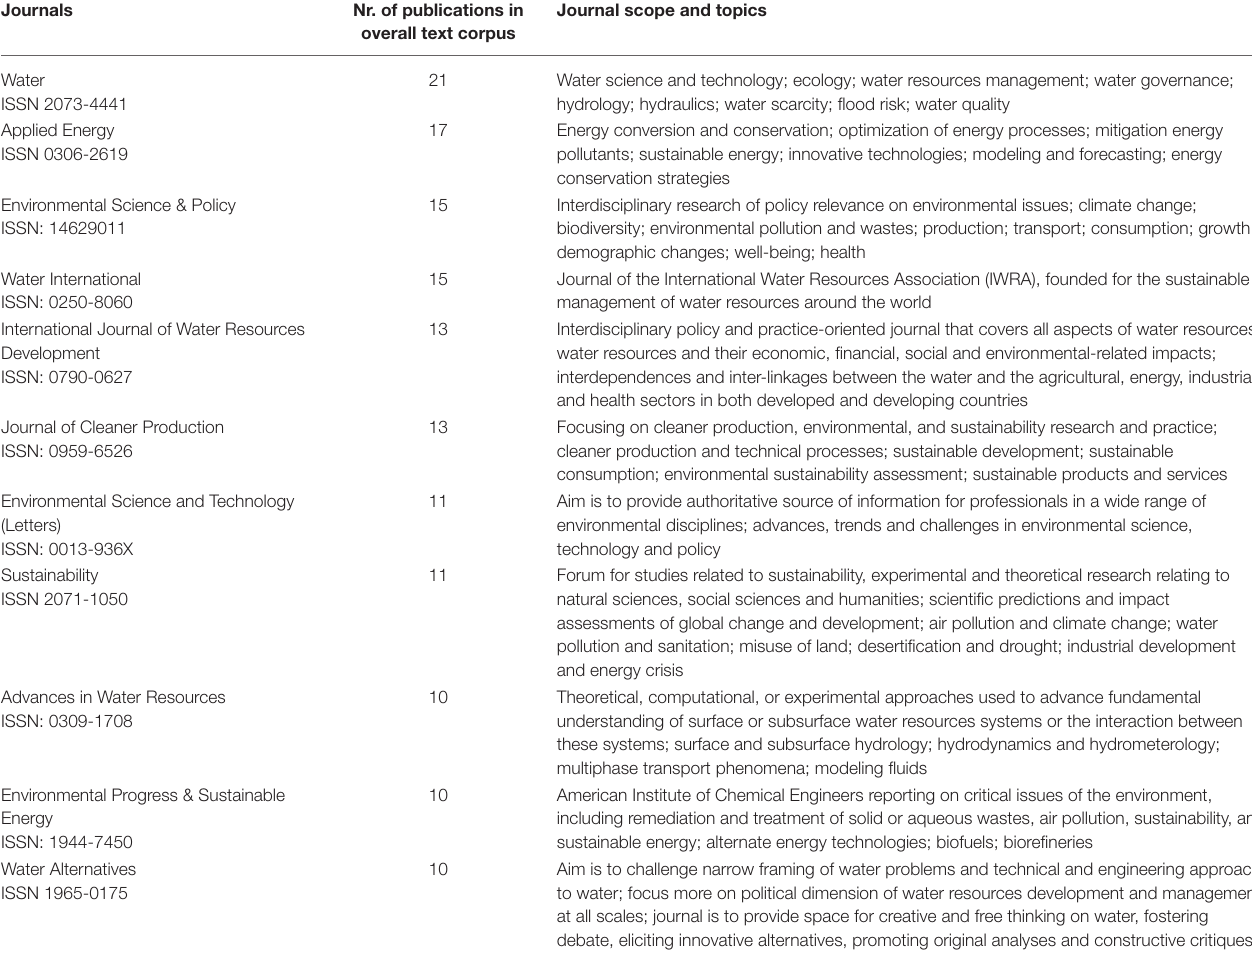
TABLE 2 | Journals within the overall text corpus with a count higher than or equal to 10.